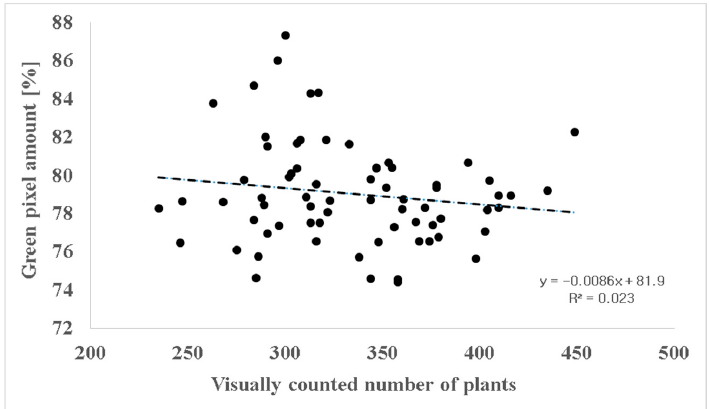
Figure 6. Correlation of the percentage of green pixel amounts (%) indicating the ground cover and the number of plants as counted in the experimental plots.